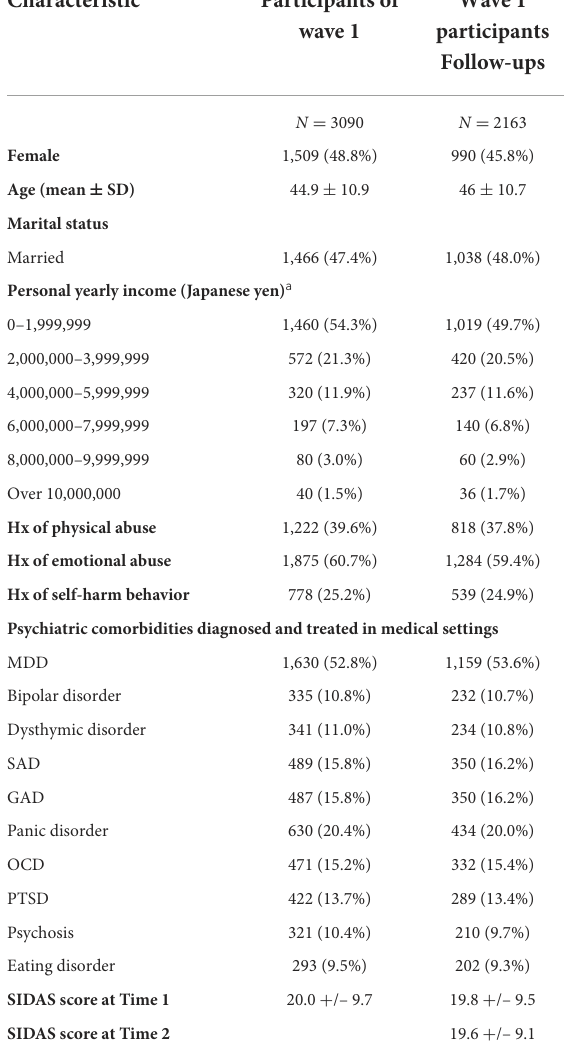
TABLE 1 Characteristics of study